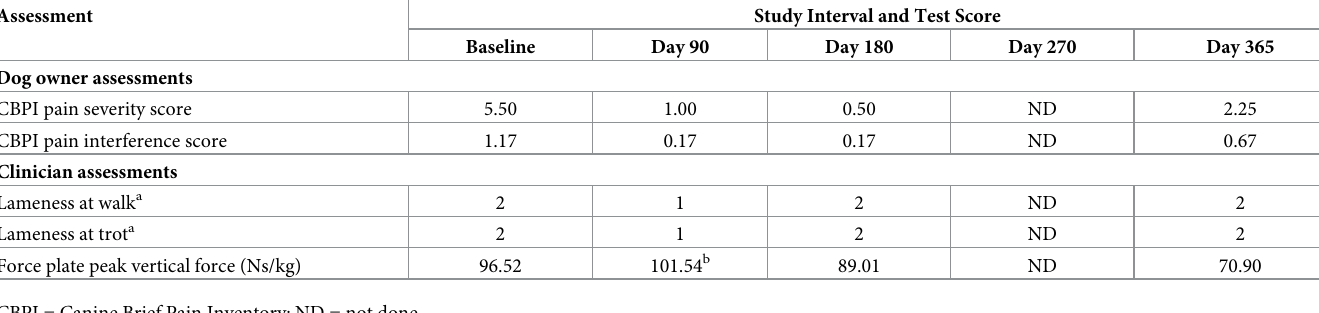
CBPI = Canine Brief Pain Inventory; ND = not done. a Scored on a 0–5 scale where 3 = severe weight-bearing lameness. b Significantly improved compared to baseline, p <